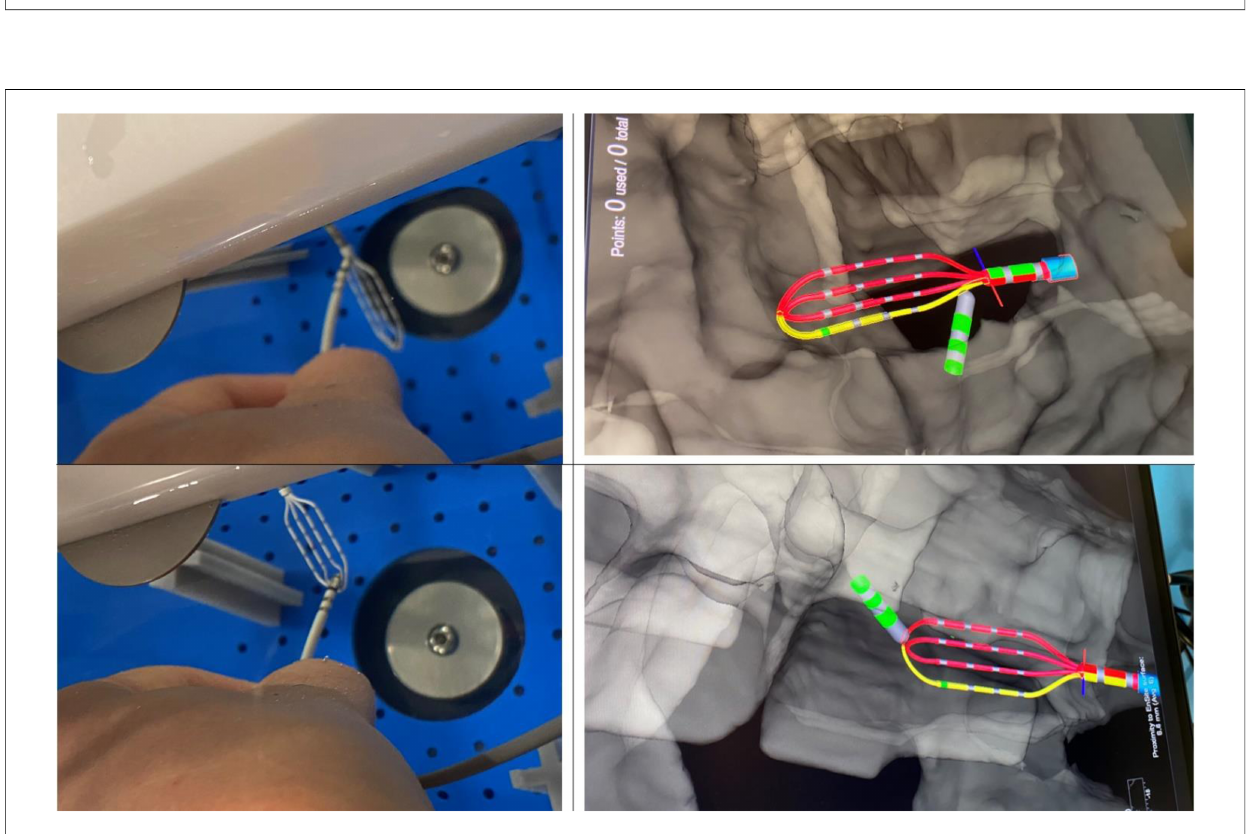
FIGURE 6 Visualization of DiamondTemp TM catheter in voXel mode. Photo of real location of HD-Grid mapping catheter and DiamondTemp TM (DTA) within the phantom and their representation on the Ensite System in Voxel mode.